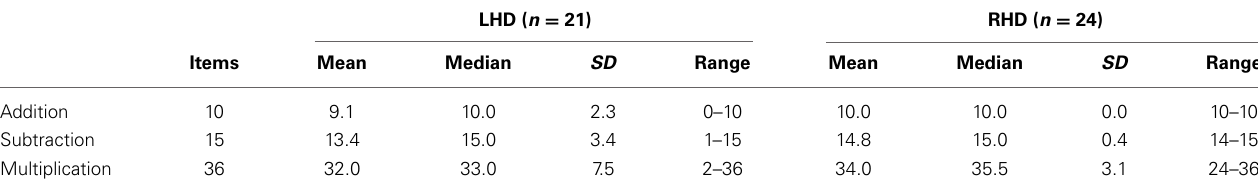
Table 2 | Raw scores (number of items solved correctly) observed for the two patient groups in each arithmetic